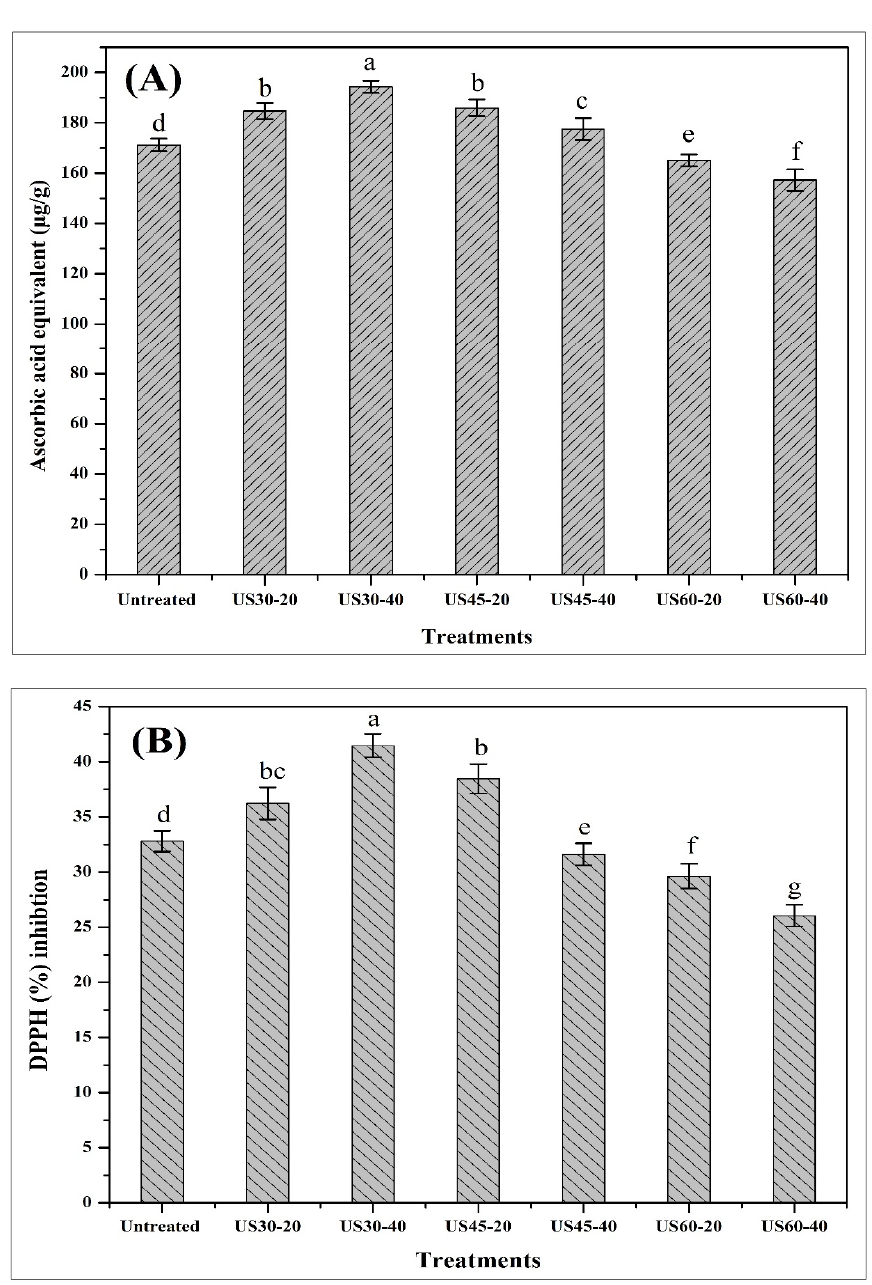
Figure 1. Impacts of thermal–ultrasound (TU) on ( a ) total antioxidant capacity and ( b ) 2, 2-diphenyl-1-picrylhydrazyl (DPPH) radical scavenging activity of wheat plantlets juice. Results are expressed as mean and standard deviation (SD) (n = 3). Different letters (a–f) describe the significant ( p < 0.05) among different treatments.